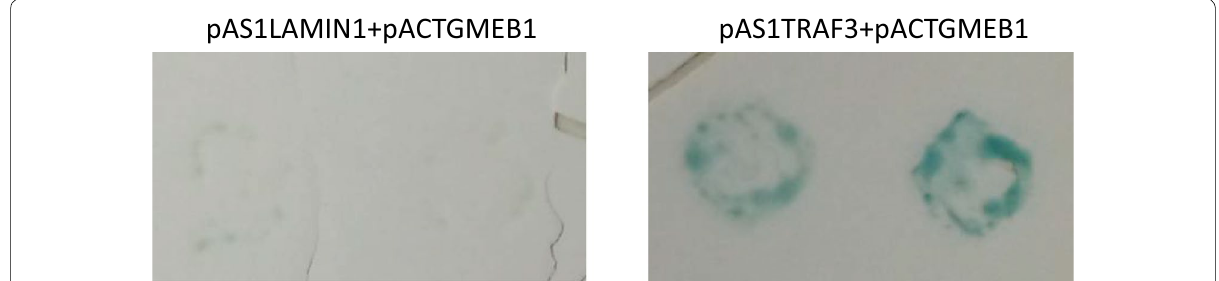
Fig. 1 Identification of GMEB1 as a TRAF3-interacting protein by the yeast two hybrid system. Yeast colonies co-transformed with a plasmid expressing a fusion of GMEB1 to the Gal4 transactivating domain (pACTGMEB1) and a plasmid expressing a Gal4 DNA-binding domain fusion with TRAF3(12–568) (pAS1TRAF3) or LAMIN1 (pAS1LAMIN1) were tested for their ability to transactivate a Gal4-dependent β-galactosidase reporter gene using a filter lift